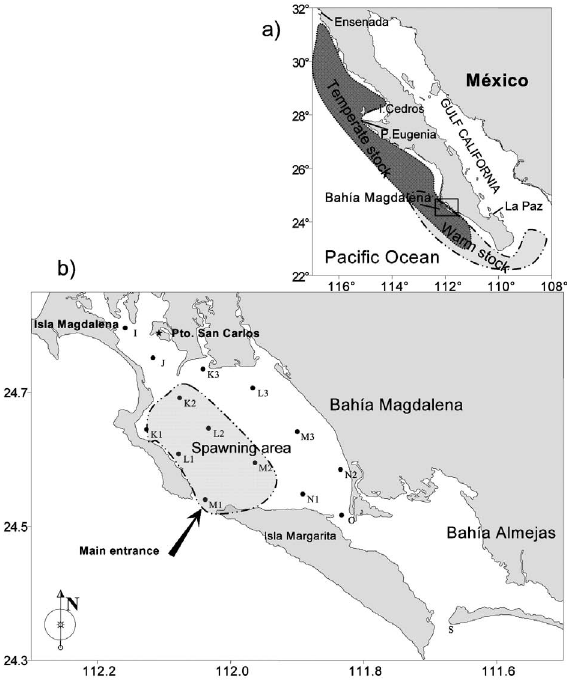
Fig . 1. – Study area and station plan in Bahía Magdalena, Baja Cali- fornia Sur, Mexico. a) Dotted lines represent the previously sug- gested stock limits of the temperate and warm stocks (Félix-Uraga et al . 2005); and b) Sardinops sagax spawning area in the western zone (Funes-Rodríguez et al .